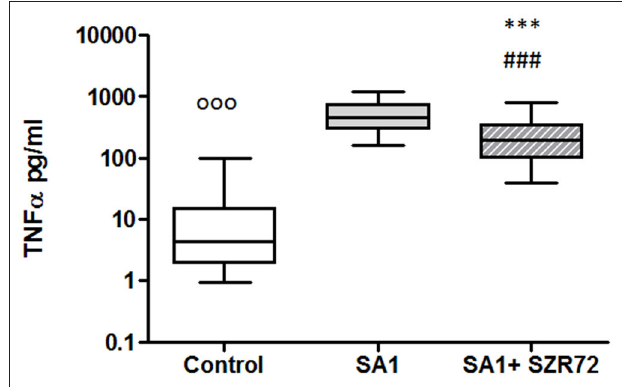
FIGURE 2 | KYNA analog, SZR72 attenuates tumor necrosis factor- α (TNF- α ) production in whole blood cells of normal controls stimulated by heat-inactivated Staphylococcus aureus. Ethylenediaminetetraacetic acid (EDTA)-anticoagulated blood samples of 1–1ml from each of 50 donors were incubated with SZR72 at a concentration of 500 µ m for 30min prior to the addition of heat-inactivated Staphylococcus aureus (10 7 /ml). The concentrations of TNF- α in the plasma were determined after 18 h-incubation period. The data are depicted as box and whiskers plots, where the lines inside the boxes denote medians, and the boxes mark the interval between 25 and 75 percentiles, and the whiskers, the maximum and minimum. Significance was determined by the Friedman’s test followed by Dunn’s post-test. In Friedman’d test, p < 0.0001; ooo p < 0.001 in control vs. SA1, ### p < 0.001 in control vs. SA1 + SZR72, *** p < 0.001 in control vs.